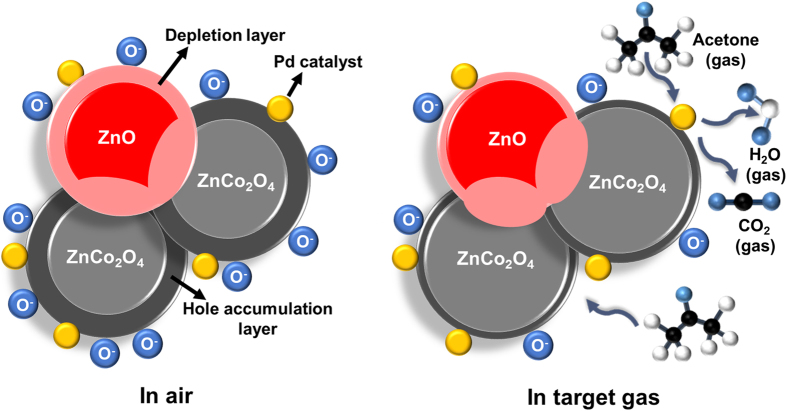
Schematic illustration of acetone sensing mechanism for Pd-ZnO/ZnCo2O4 HSs.